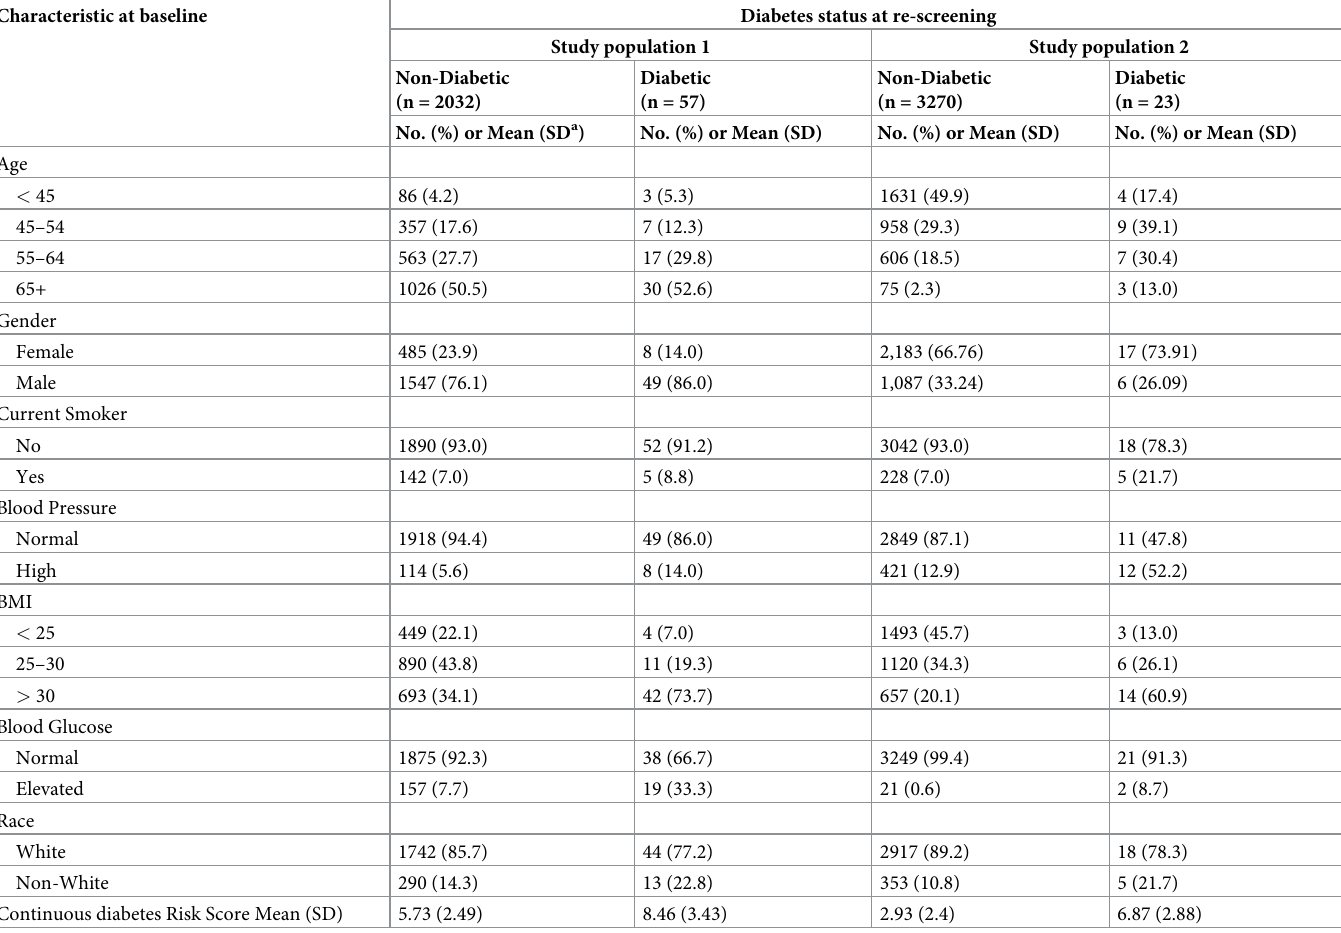
Table 3. Demographic characteristics and risk scores by diabetes status at re-screening for study population 1 (US former DOE workers, 2005–2015) and study pop- ulation 2 (Colorado workers from multiple businesses, 2010–2014). Characteristic at baseline